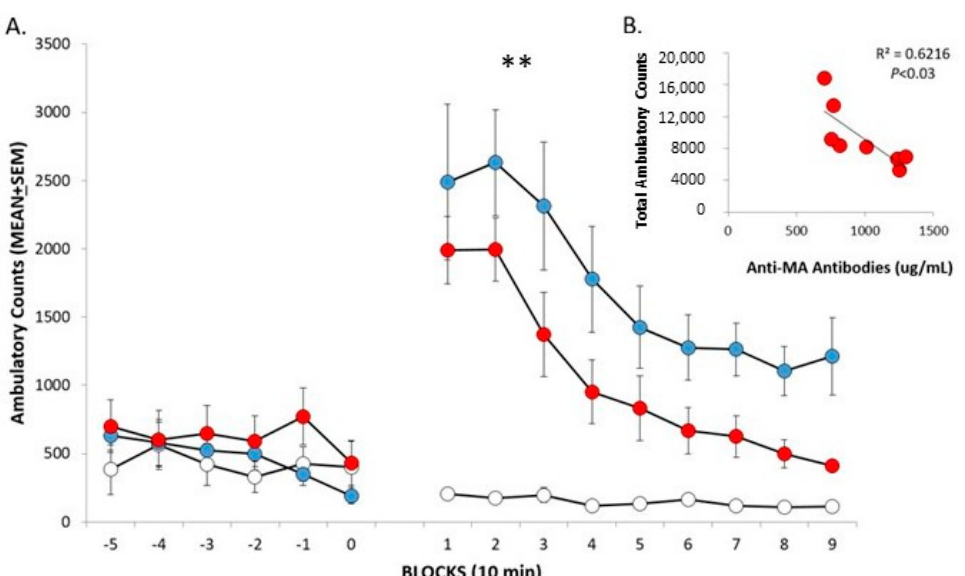
Figure 2. MA-induced locomotor activation. ( A ) Mice were first habituated to the apparatus (-5-0) then unvaccinated mice were administered saline (white circles, 0 mg/kg, n = 5) or MA (blue circles, 2 mg/kg, n = 10) and vaccinated mice received MA (red circles, 2 mg/kg, n = 8). MA-induced locomotor activation was significantly attenuated in vaccinated mice compared to unvaccinated mice. ** main effect for vaccine, p < 0.0001. ( B ) Anti-MA antibody levels significantly correlated with total ambulatory counts.